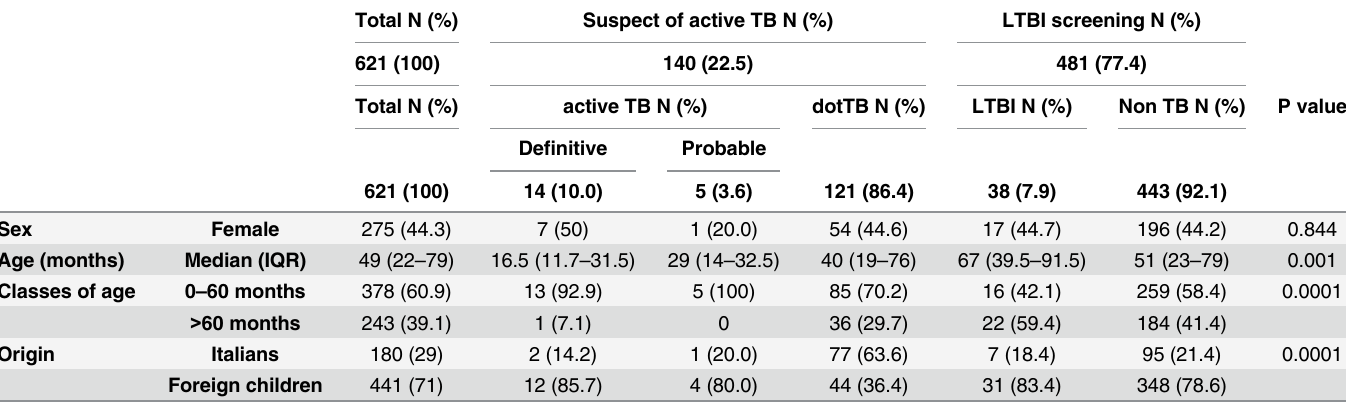
Table 1. Demographic characteristics of the study